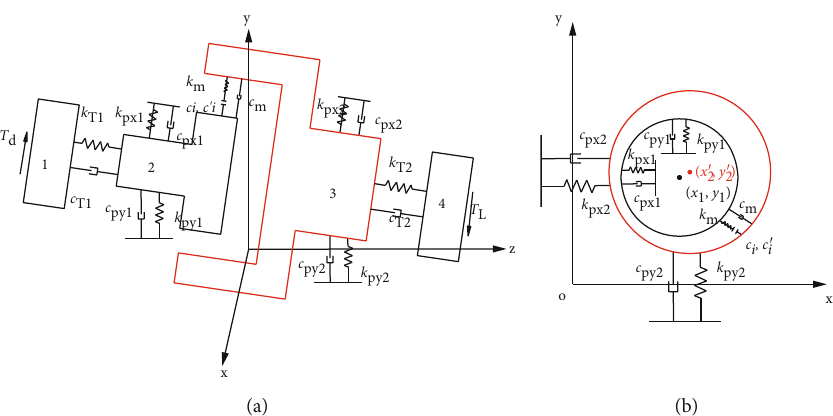
Figure 1: The vibration model of the bending – torsion coupling of the involute spline coupling: (a) in the three-dimensional plane; (b) in the xoy plane.